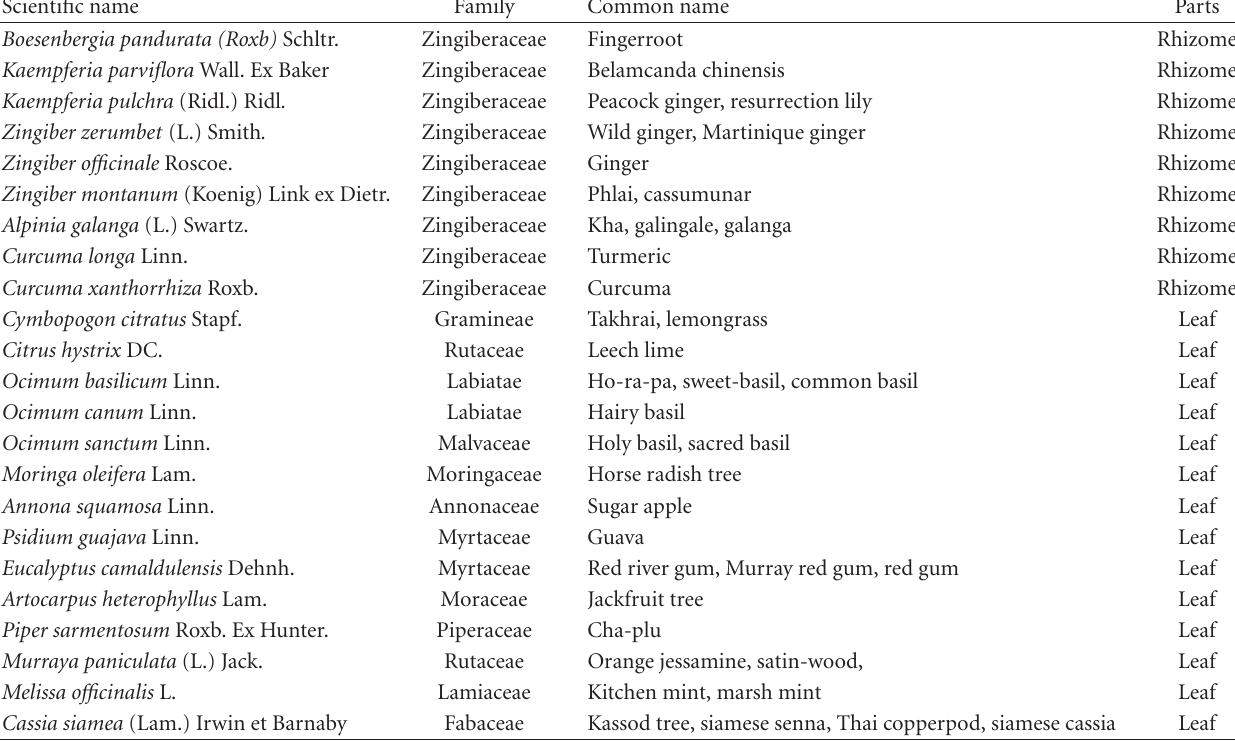
Table 1: Plants and their parts used for evaluation of acaricidal activities against Luciaphorus